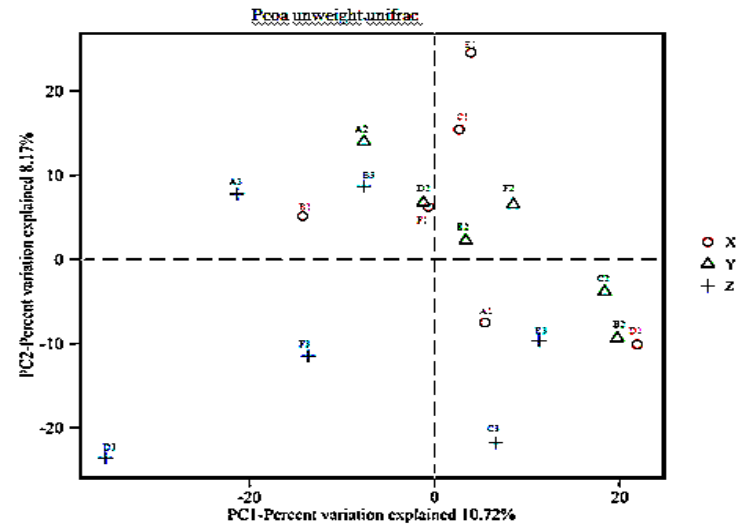
Figure 2. The Unweighted-PCoA analysis of samples (cutoff = 0.03). X: April; Y: July; Z: October.